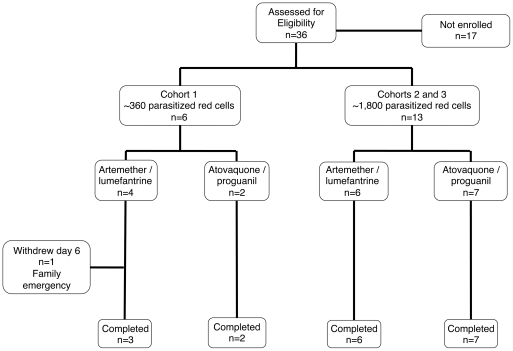
Participant flow.